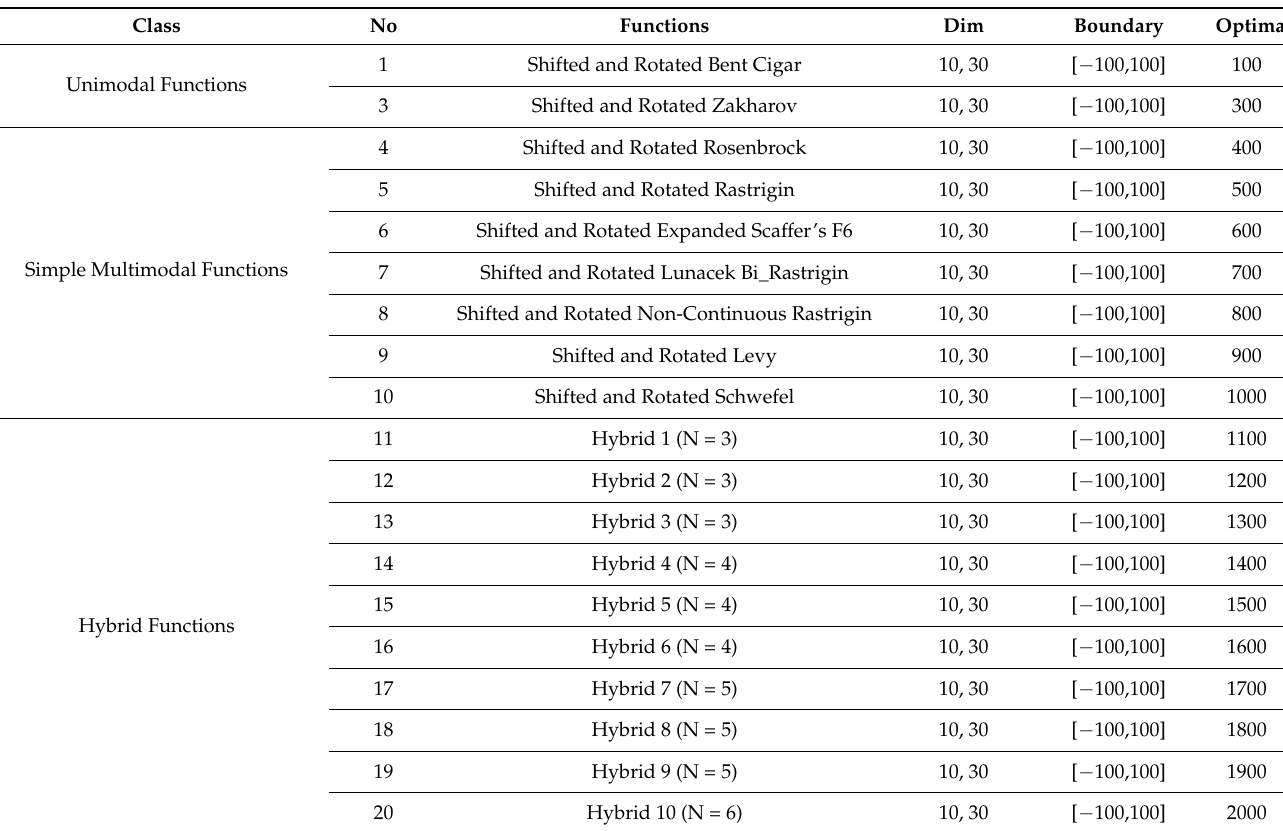
Table 1. Summary of the CEC-2017 function test